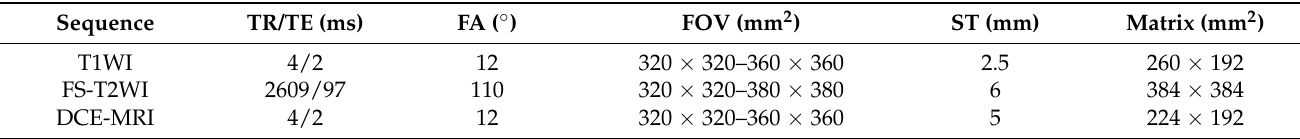
Table 1. MRI sequences and their related